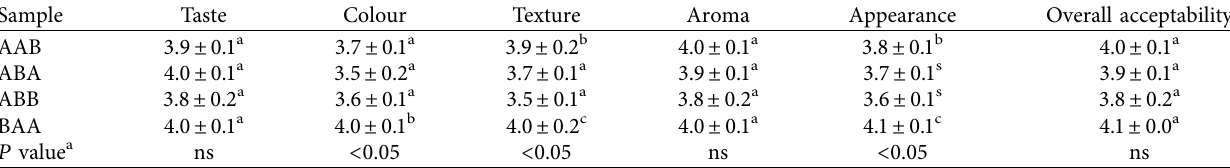
Table 4: Mean sensory scores of fermented cowpea-peanut milk with Lacticaseibacillus rhamnosus Yoba. Sample Taste Colour Texture